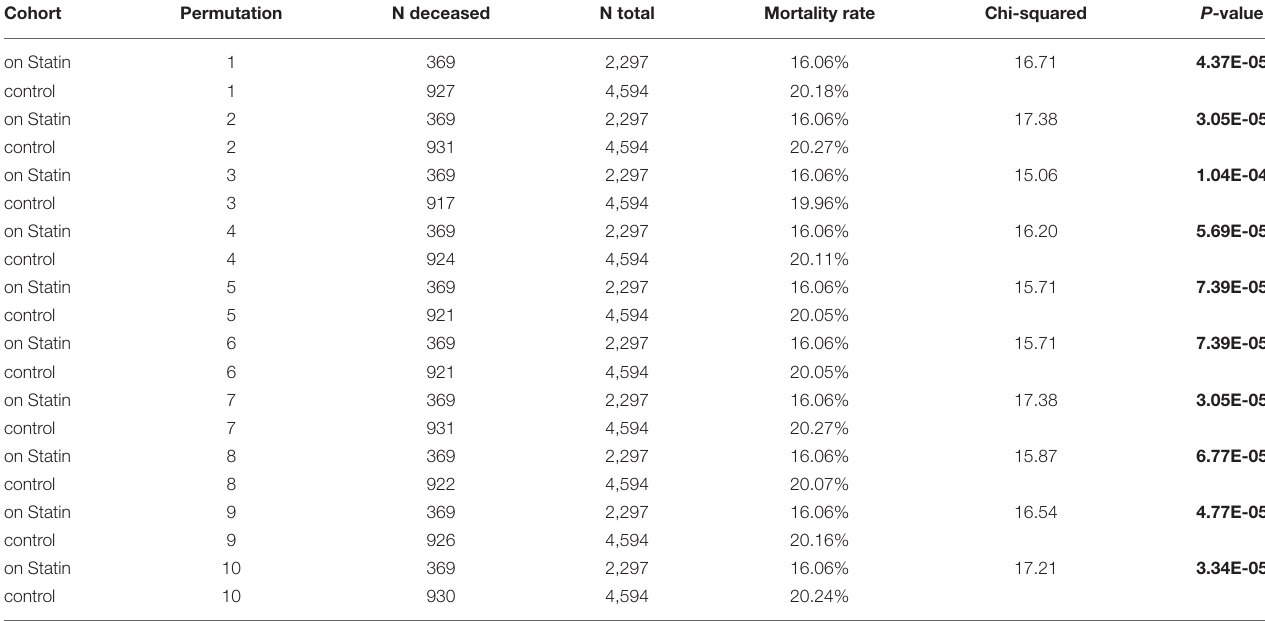
TABLE 3 | Propensity score matching by demographics and comorbidities: a mortality rate, associated X-squared and p -value in each iteration.